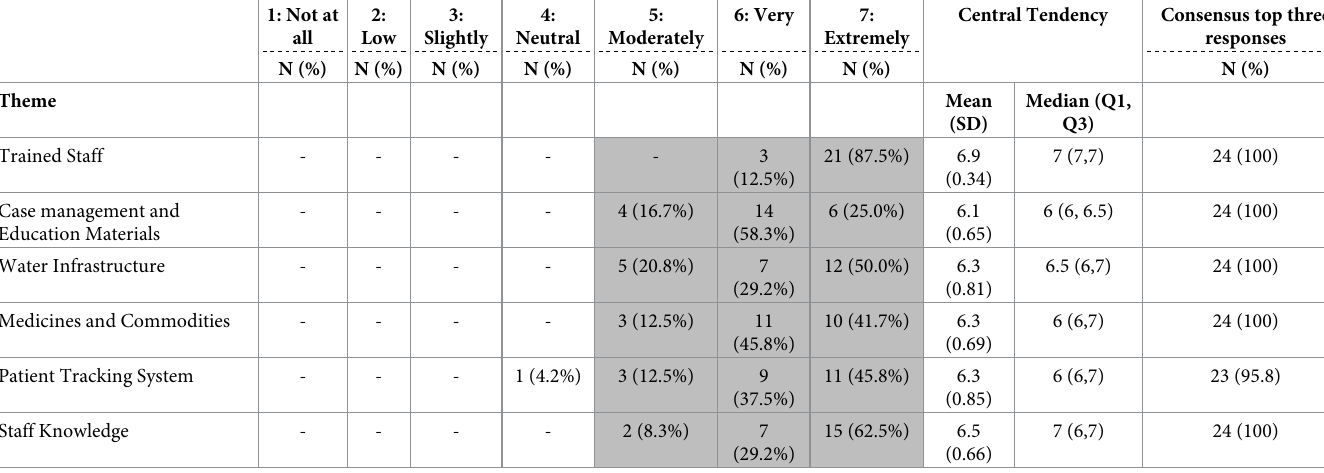
Table 3. Participant response to the question: “How important are the following domains in determining quality of MMDP services a health facility could pro- vide?”, n =